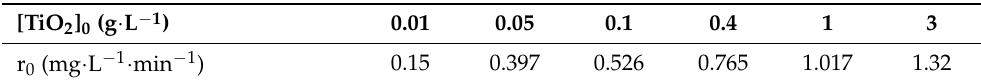
Figure 4. Effect of TiO 2 loading (0.01 − 3 g · L − 1 ) on SO degradation by UV/TiO 2 /IO 3 − process ([IO 3 − ] = 0.15 mM, [SO] = 10 mg · L − 1 , T = 25 ± 2 ◦ C and pH~6). Table 2. Dependence of initial degradation rate on TiO 2 loading in the range 0.01–3 g · L − 1 through UV/TiO 2 /IO 3 − process.